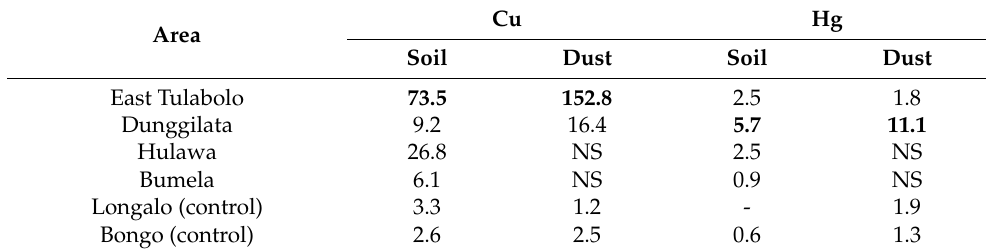
Table 2. Hazard quotient of element based on